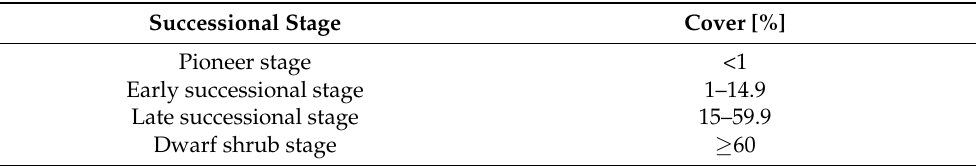
Figure 2. Successional stages on the glacier forelands of Fürkele-, Zufall- and Langenferner. The results of the in-situ sampling are shown as NMDS of sample plots. In the NMDS , the colored dots and polygons indicate the different successional stages: red = pioneer stage (15 plots), yellow = early successional stage (16 plots), light green = late successional stages (27 plots), dark green = dwarf shrub stage (7 plots). The vectors (red arrows) indicate the environmental variables (age, elevation, inclination, mean JJA temperature) with a significant influence on the grouping. The length of the arrows shows the correlation between the variable and the ordination. Table 3. Successional stages and their range of vegetation cover [%].